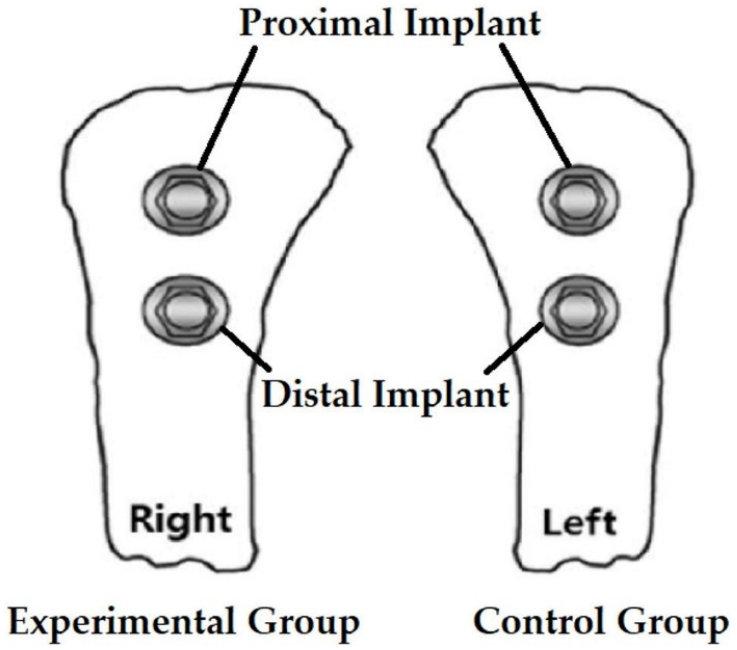
Figure 2. Implant placement sites in rabbit tibia.